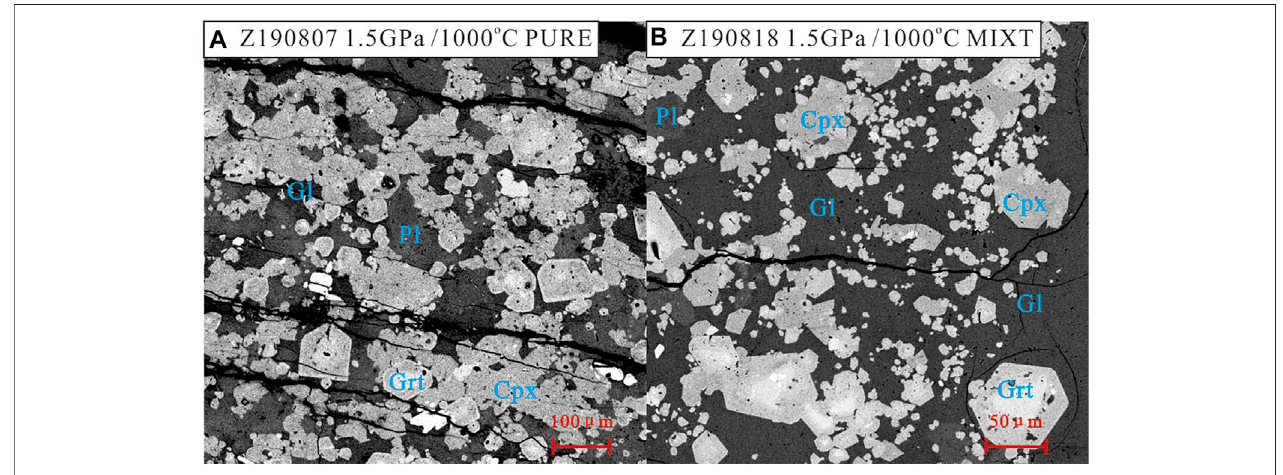
FIGURE 3 | Representative BSE photos of experiment products. Phase abbreviation: Gl = glass (melt), Cpx = clinopyxene, Grt = garnet, Pl = plagioclase.